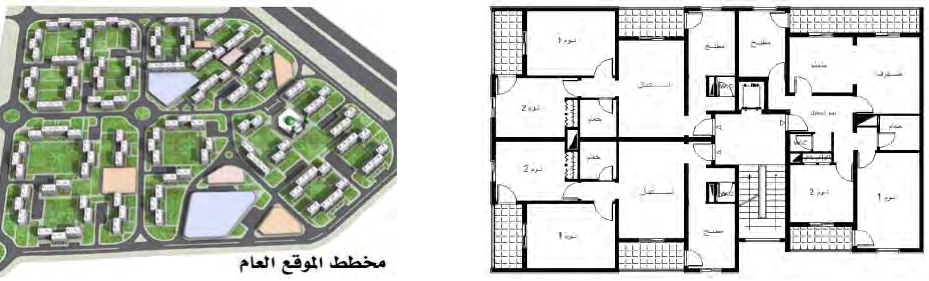
Figure 6: Site plan of Maasaraniyef and typical floor plan